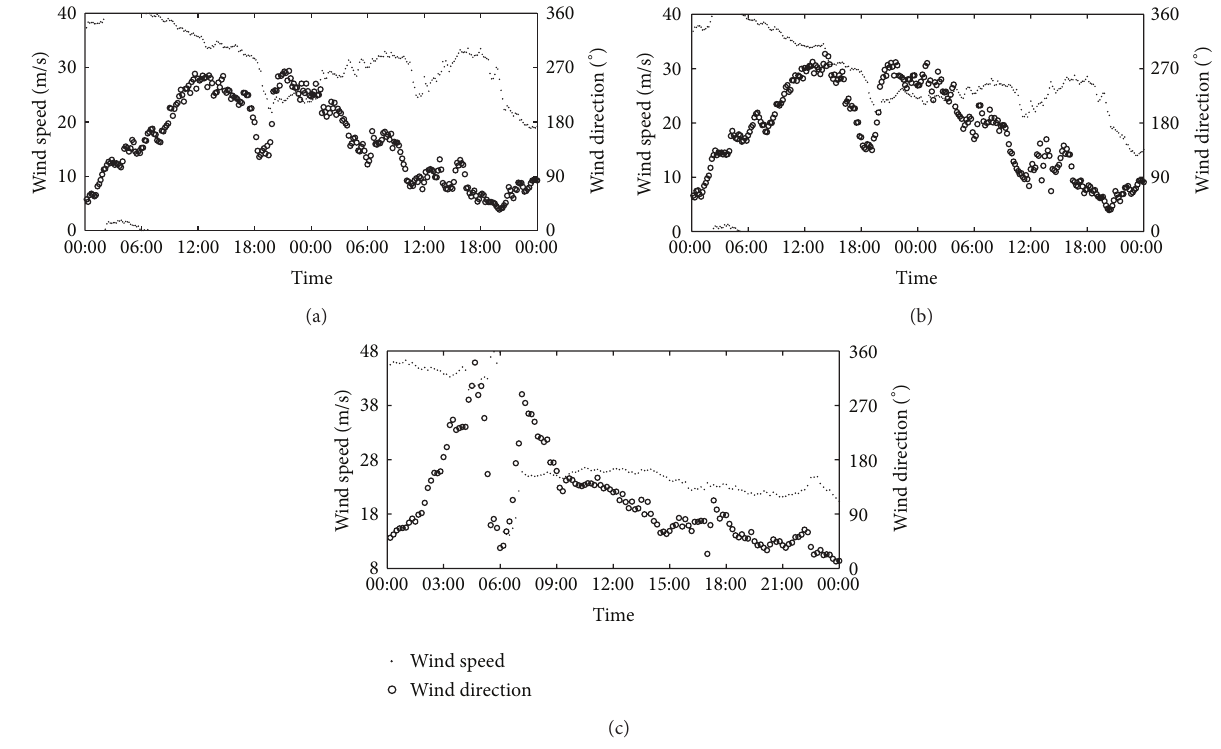
Figure 3: Wind speed and wind direction during strong typhoons: (a) typhoon Nuri from 00:00 am on August 22 to 23:59 pm on August 23, 2008, at 10m height, (b) typhoon Nuri from 00:00 am on August 22 to 23:59 pm on August 23, 2008, at 60m height, and (c) typhoon Hagupit from 0:00am to 23:59 pm on September 24, 2008, at 60 m height. Table 1: Detailed information of the two typhoon